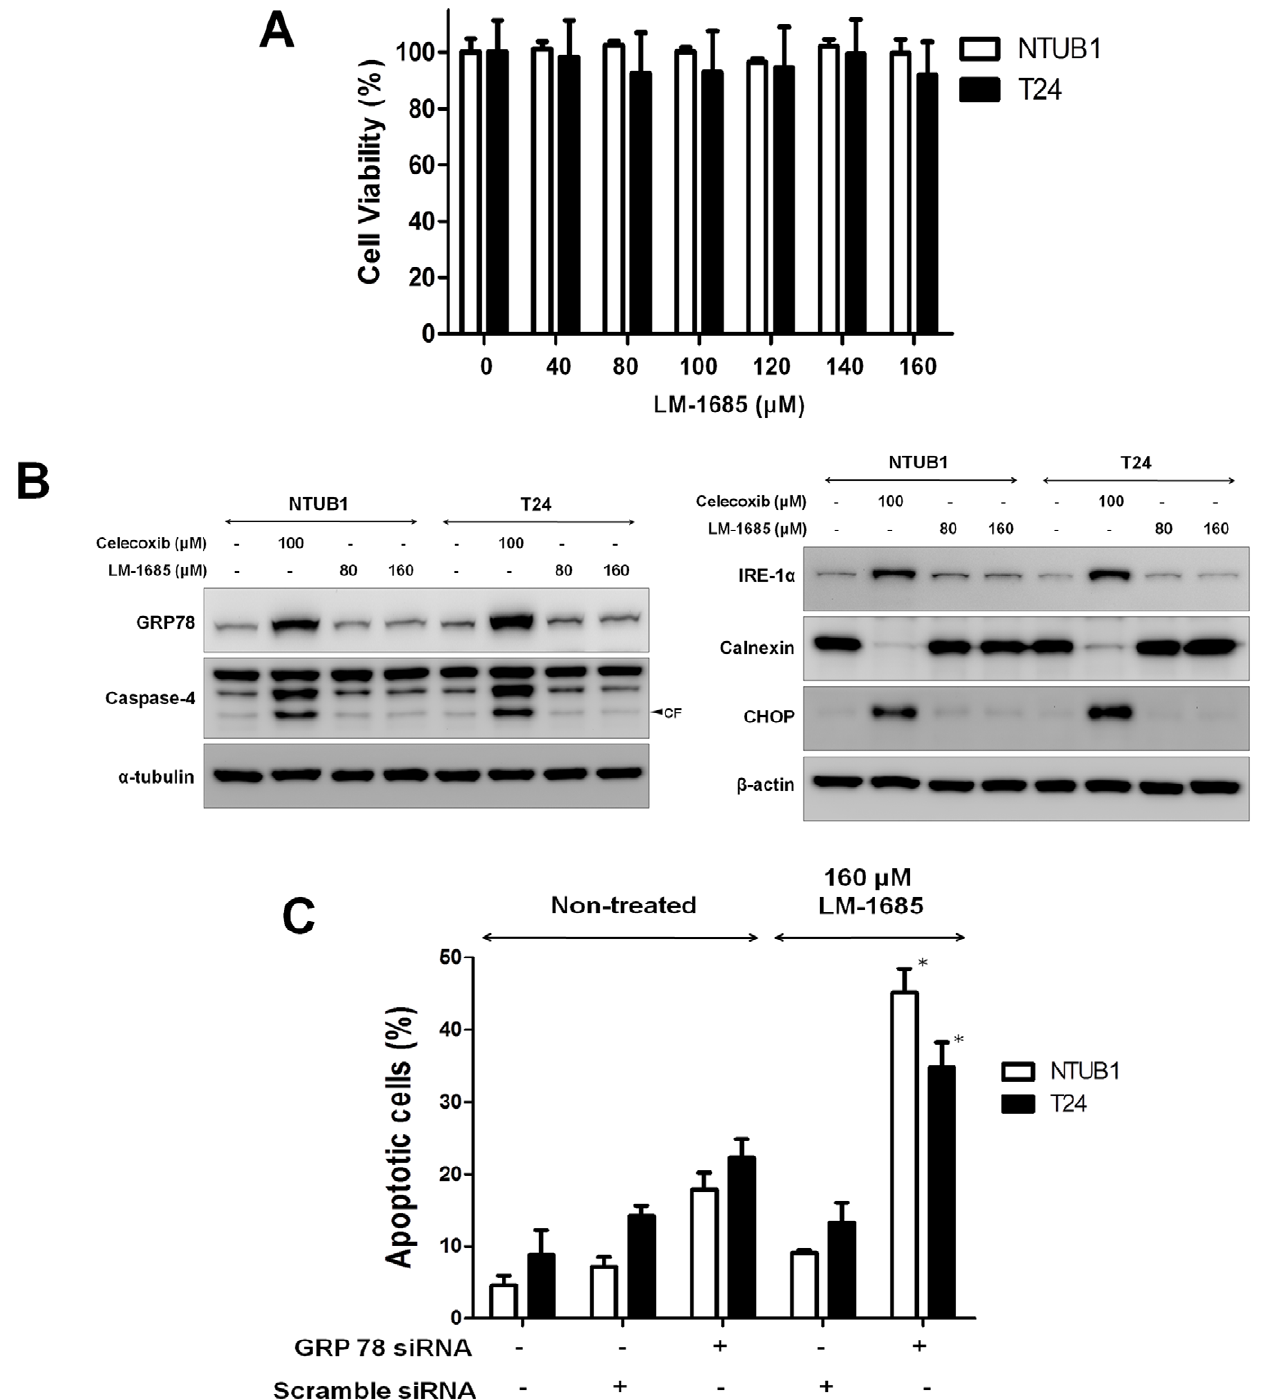
Figure 7. Effects of LM-1685, a non-coxib COX-2 inhibitor, on the viability and induction of ER stress-related molecules in NTUB1 and T24 cells. (A) Cells were treated with LM-1685 (0–160 m M) for 24 h. Cell viability was analyzed by MTT assay. Data are presented as means 6 SD of three independents experiments. (B) Cells were treated with LM-1685 (80 and 160 m M) or celecoxib (100 m M) for 24 h. The cell lysates were harvested at each time point and analyzed by Western blotting with specific antibodies to detect ER stress-related molecules IRE-1 a , CHOP, calnexin, and GRP78, and caspase-4. CF is the abbreviation of cleaved form. (C). Cells were transfected with GRP78 siRNA (10 nM) or scramble siRNA (10 nM) (as a control), and then treated with 160 m M LM-1685. The combinative effect of LM-1685 and GRP78 knockdown on apoptosis was determined by flow cytometry (FACS) with annexin V-FITC and PI labeling. The quantitative analysis of total apoptosis (early and late) population was presented. Data are presented as means 6 SD of three independents experiments. * p , 0.05 as compared with scramble siRNA + LM-1685.